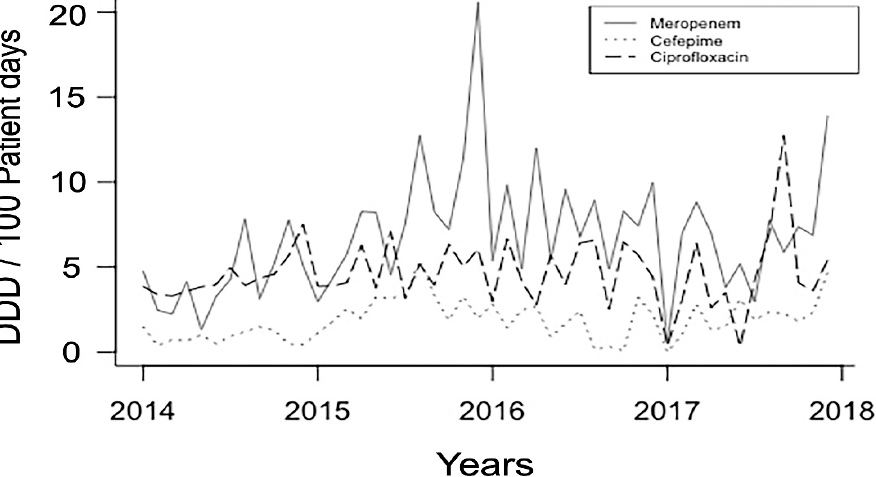
Figure 1. Use of meropenem, cefepime, and ciprofloxacin over a four-year study period. Usage is defined in defined daily doses per 100 patient days (DDD/100 PD).